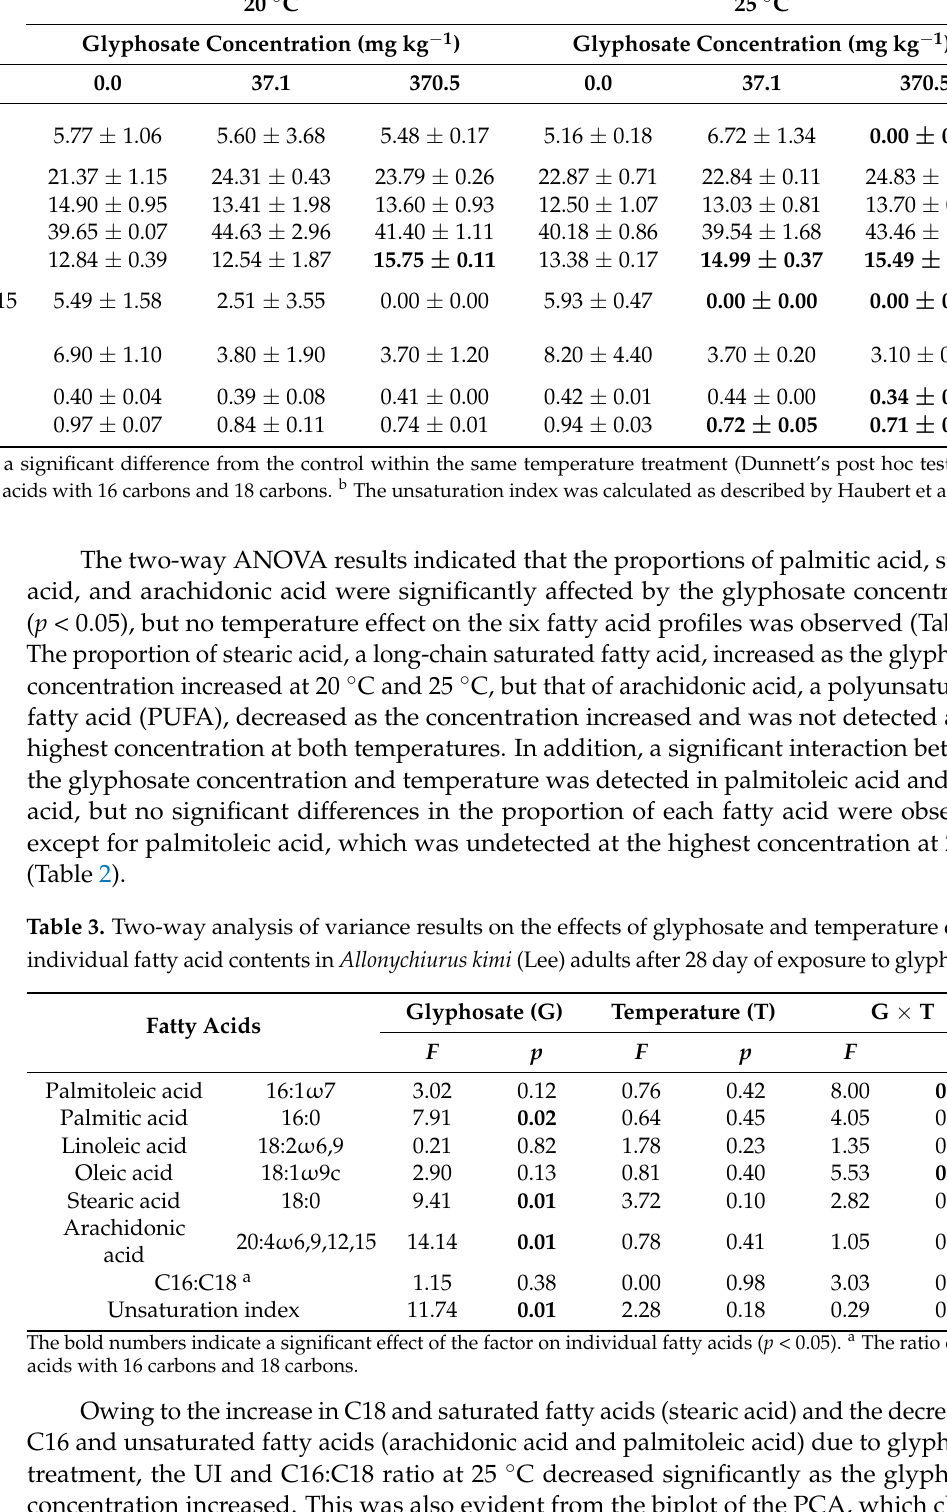
Table 2. Proportions of fatty acids (mean ± standard deviation) in Allonychiurus kimi (Lee) adults after 28 day of exposure to glyphosate (0.0, 37.1, and 370.5 mg kg − 1 ) at 20 ◦ C and 25 ◦ C.